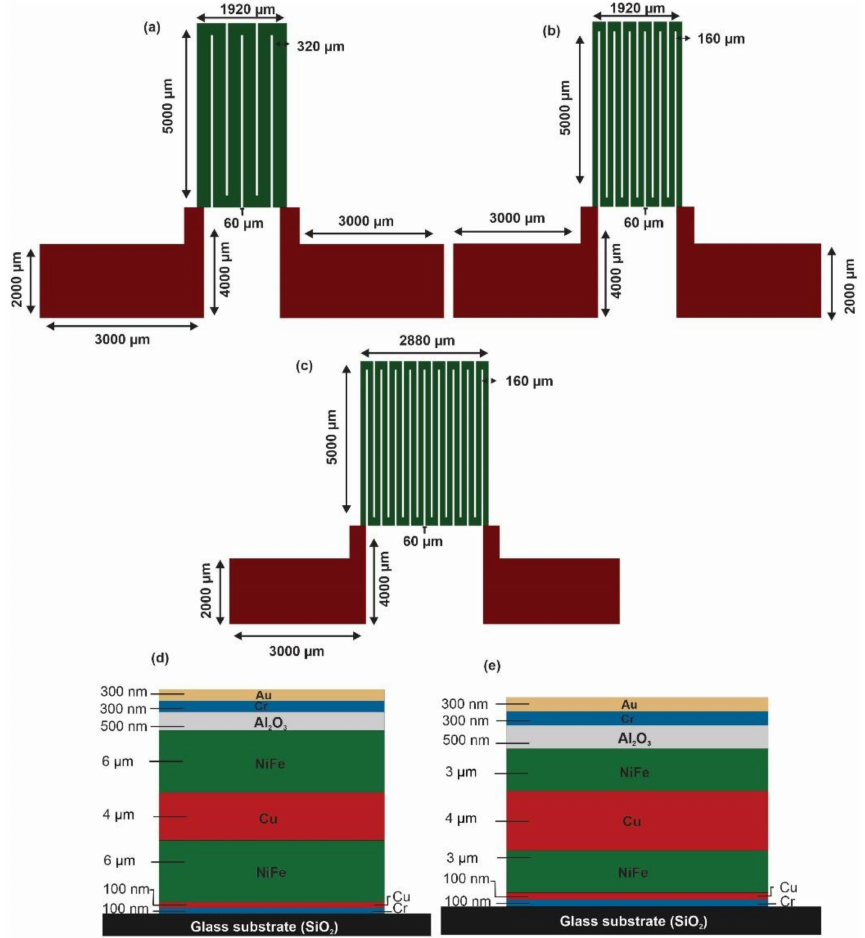
Figure 1. MI biosensor design and geometry. ( a ) The geometry of the 3-turn meander line MI biosensor. ( b ) The geometry of the 6-turn meander line MI biosensor. ( c ) The geometry of the 9-turn meander line MI biosensor. ( d ) MI biosensor materials with 6 µ m thick magnetic materials. ( e ) MI biosensor materials with 3 µ m thick magnetic